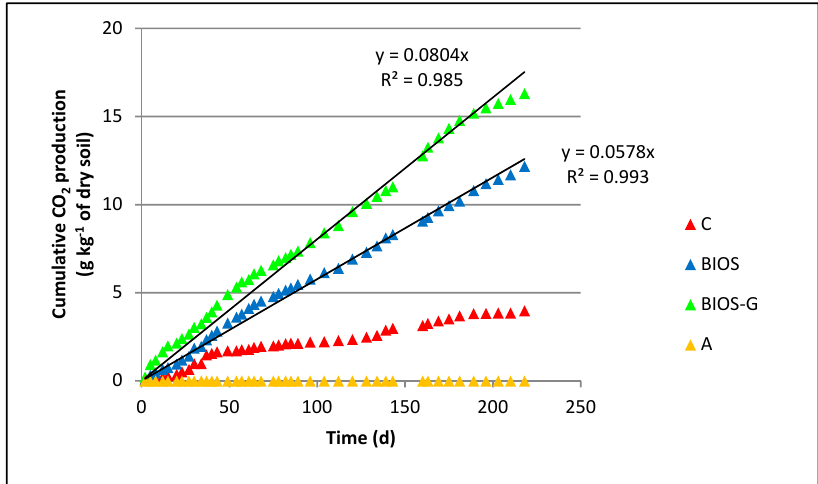
Figure 1. Cumulative amount of CO 2 production due to microbial respiration (A = abiotic microcosm; BIOS = biostimulated microcosm; BIOS-G = biostimulated microcosm and glucose addition; C = control microcosm).